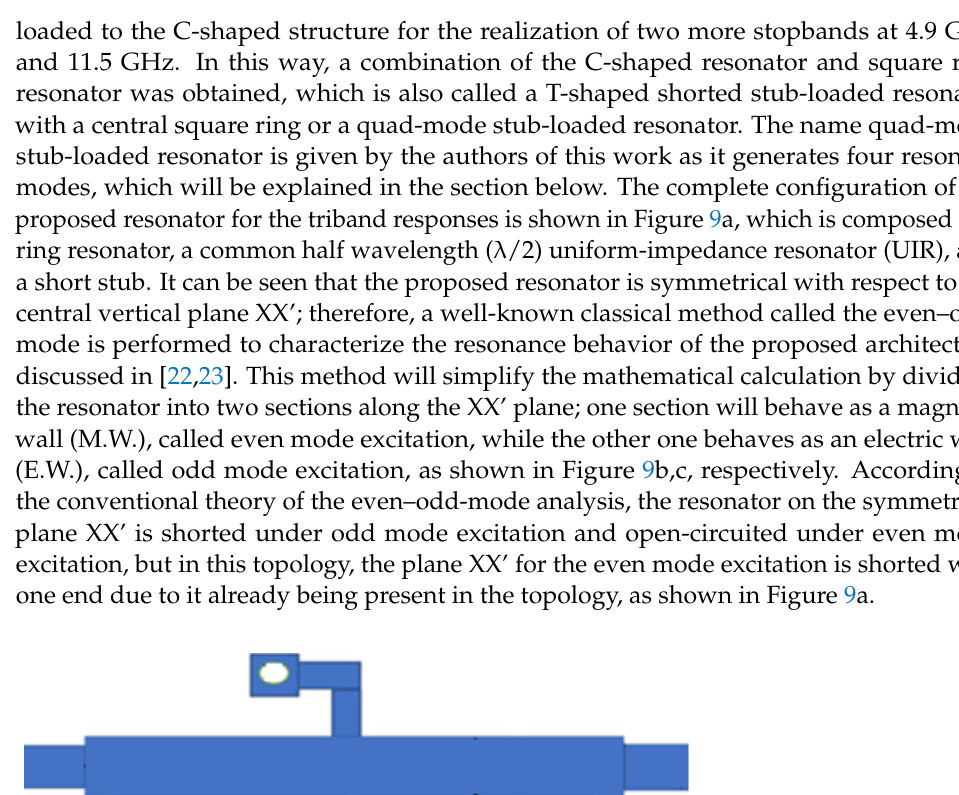
7 of 20 Figure 5. Simulated frequency plots of the SUWB-BPF with proposed rectangular pads. 3. Operational Principle of the SUWB-BPF with In-Band Frequency Suppression A novel T-shaped shorted stub-loaded resonator with a central square ring, also known as a quad-mode stub-loaded resonator, was utilized for the realization of in-band